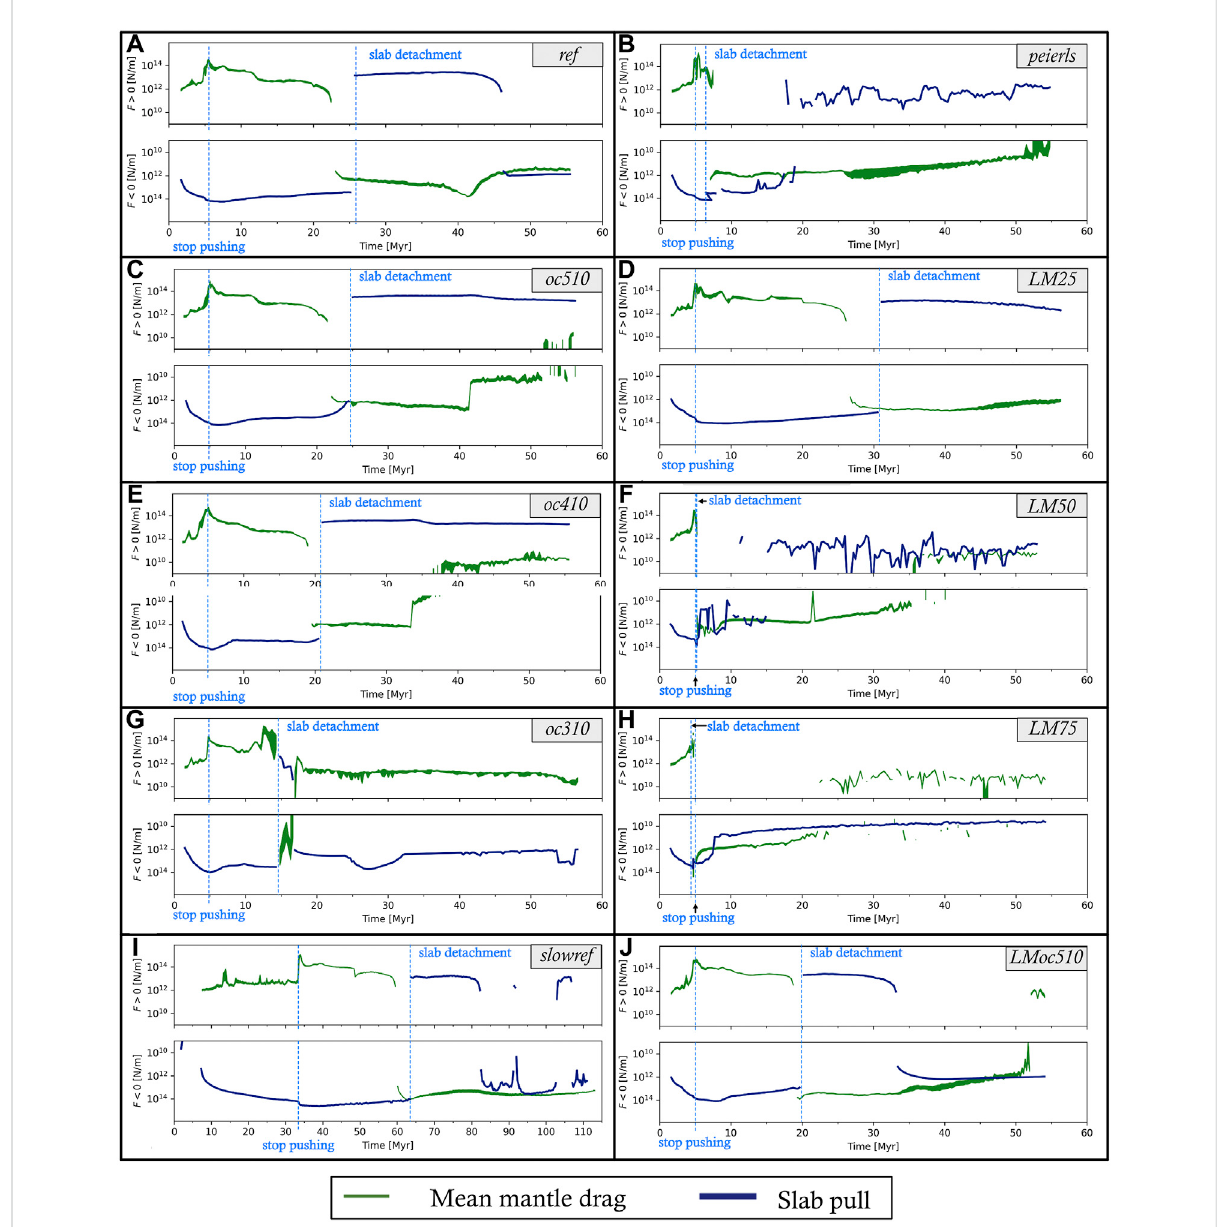
FIGURE 7 Forcequanti fi cation fi guresforthereferencemodel (A) ,theoceaniclength (C,E,G) andlithosphericmantlefriction (D,F,H,J) parameter studies, as well as the Peierls creep (B) and slow-collision parameter (I) studies. The moment of push release and that of slab detachment are indicated on each panel. See text for further information. Note the different time axis of model slowref